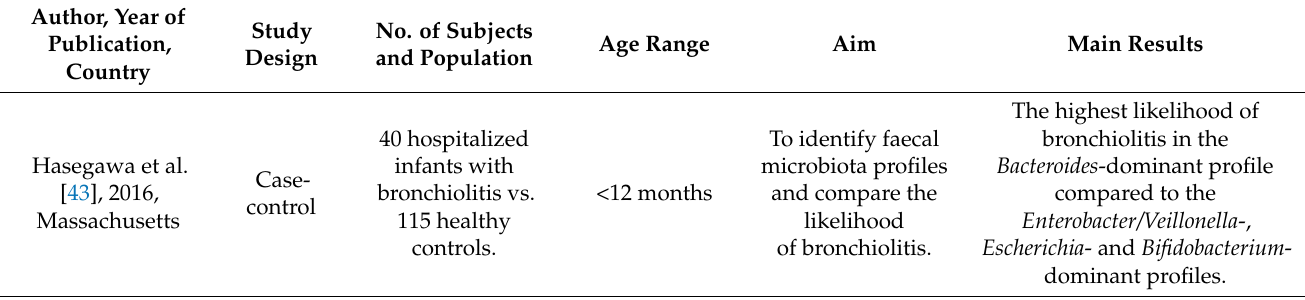
Table 2. Studies analysing the relationship between RTIs and GM in children.